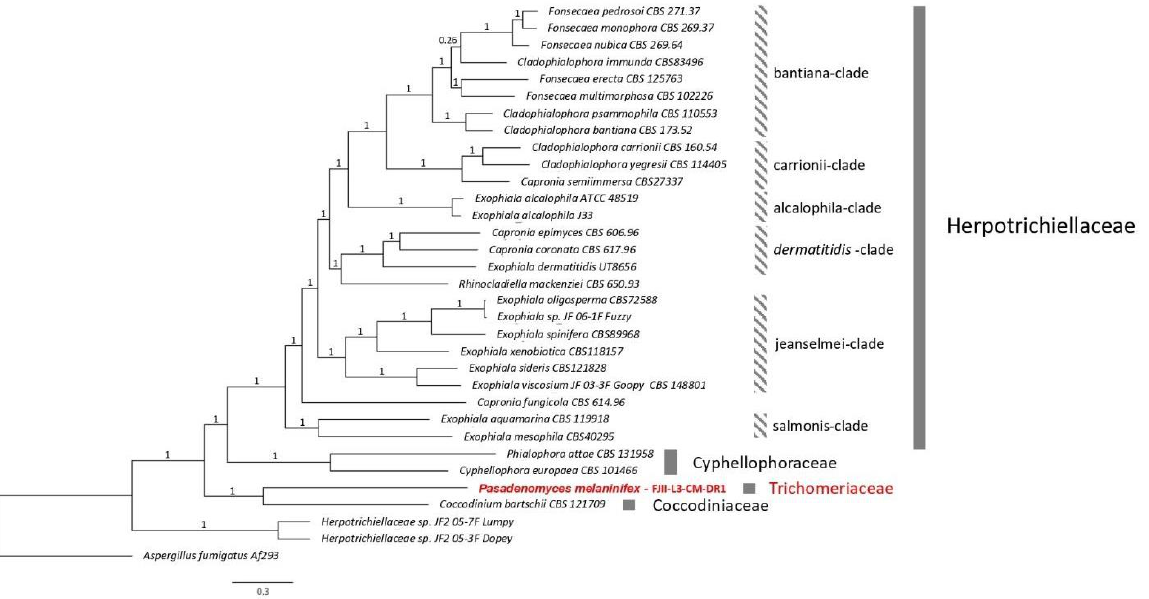
Figure 6. WGS-based phylogenomic analysis for P. melaninifex . ML tree among nine Cordycipitaceae fungi using the RAxML and ASTRAL software. A. fumigatus Af293 was set as the outgroup and the branches are proportional to the number of mutations. Branch fidelity used posterior probabilities, which were added next to the corresponding branches.